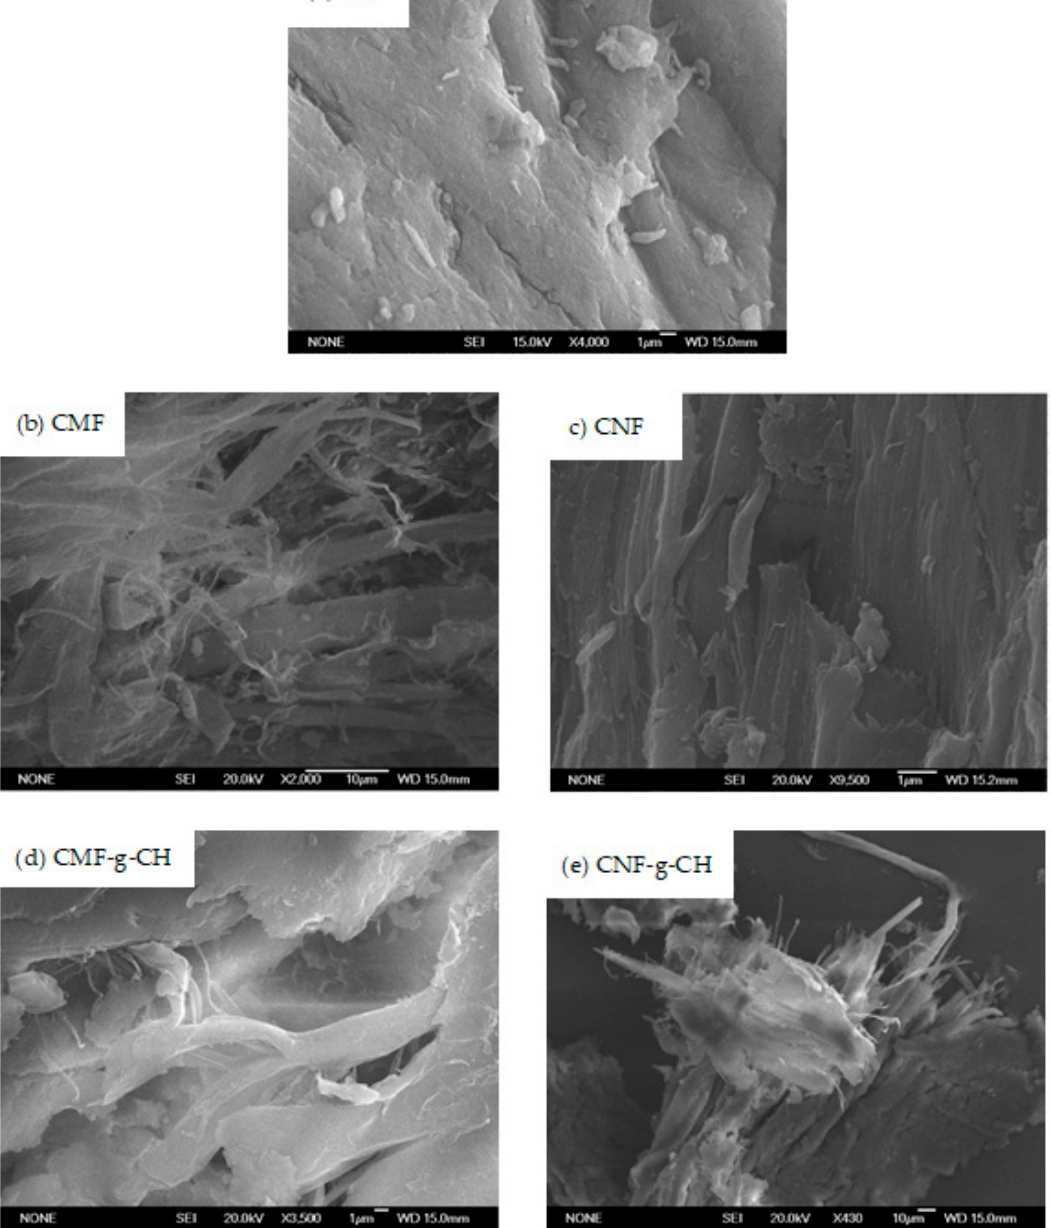
Figure 10. SEM Images: ( a ) CH; ( b ) CMF; ( c ) CNF; ( d ) CMF-g-CH; ( e ) CNF-g-CH.